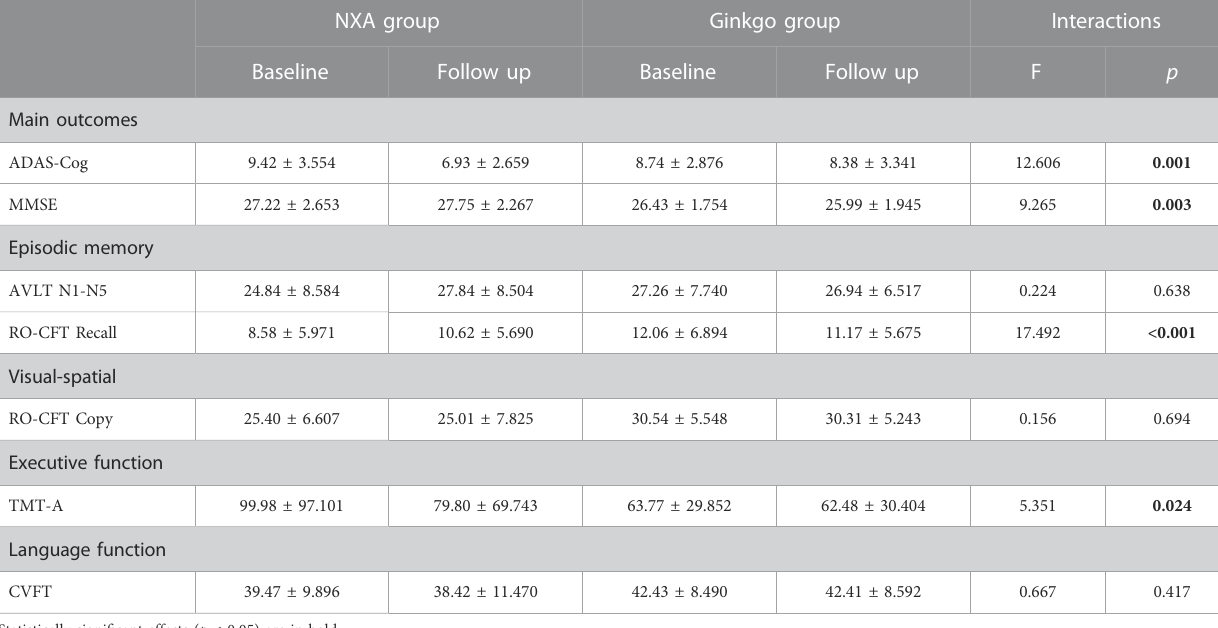
TABLE 2 Effect of NXA capsule on cognitive performance in patients with vascular cognitive impairment. NXA group Ginkgo group Interactions Baseline Follow up Baseline Follow up F